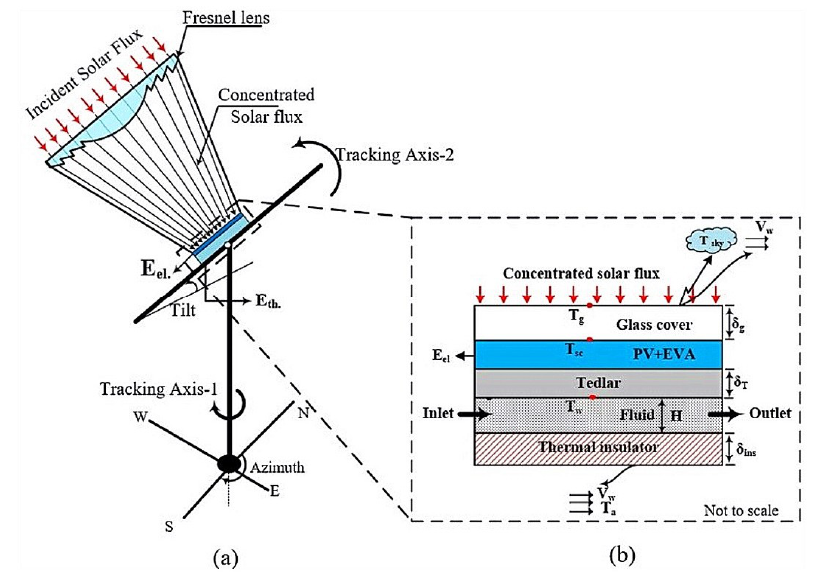
Figure 22. A neat schematic sketch of the proposed physical domain ( a ) and components of CPV/T system ( b )